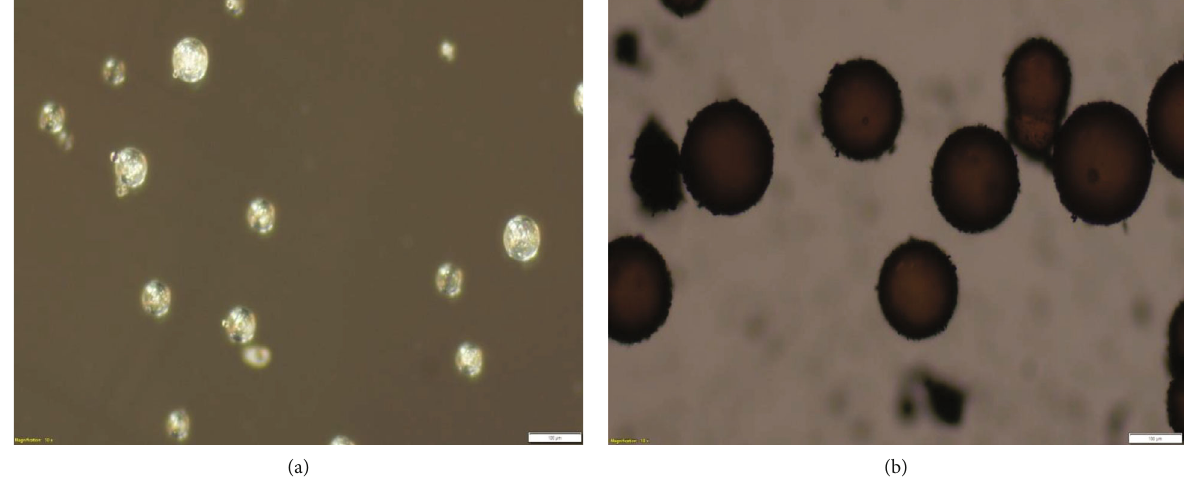
Figure 1: Optical micrographs of (a) uncoated and (b) MnO-coated hollow PMMA